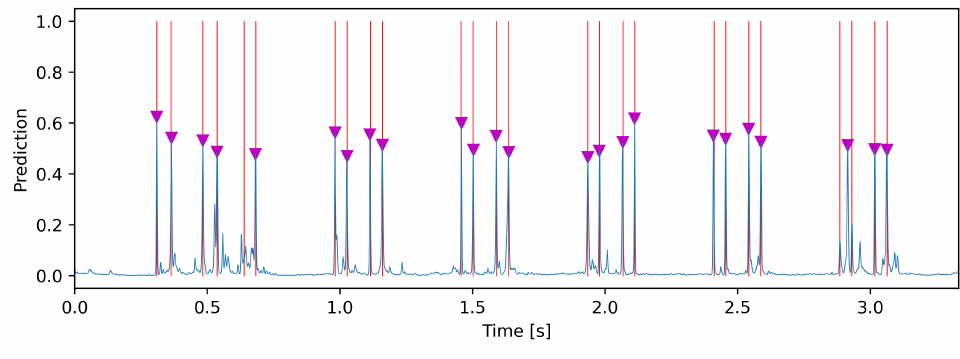
Figure 9. Exemplary output, with the model’s output pseudo-probabilities represented by the blue lines, ground-truth by the red lines, and found peaks by the magenta triangles.